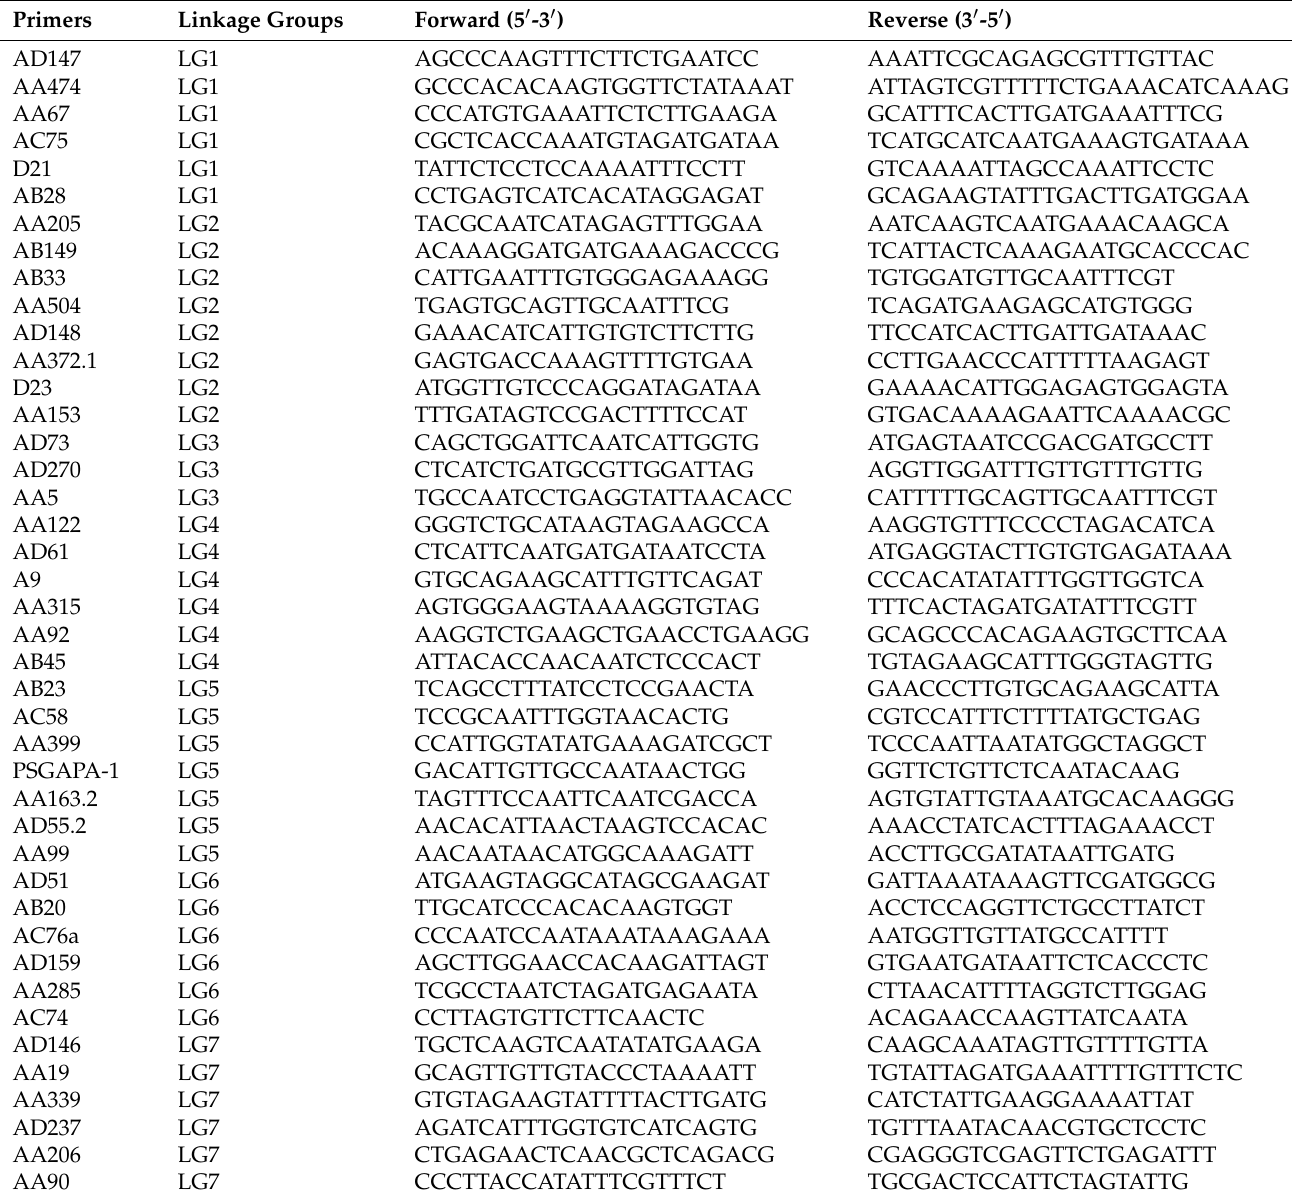
Table 1. List of SSRs primers used for this study with primer